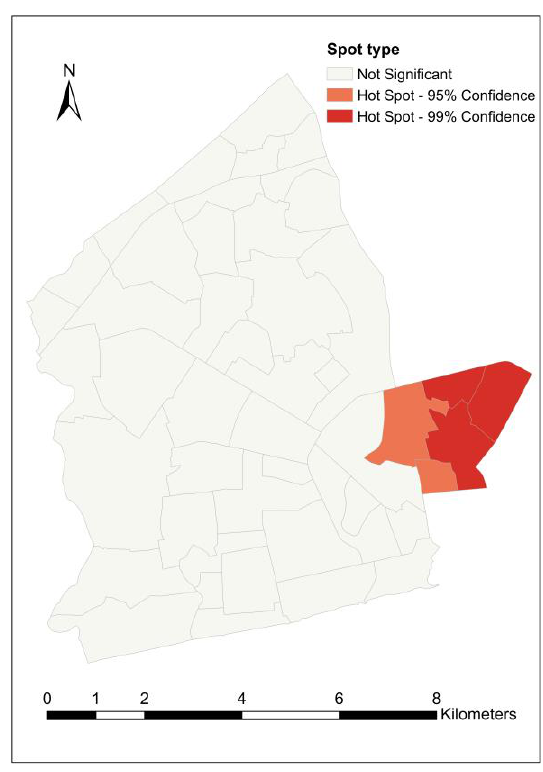
Figure 13. Hot spot neighborhoods for ratio of load shedding exposure to population density.